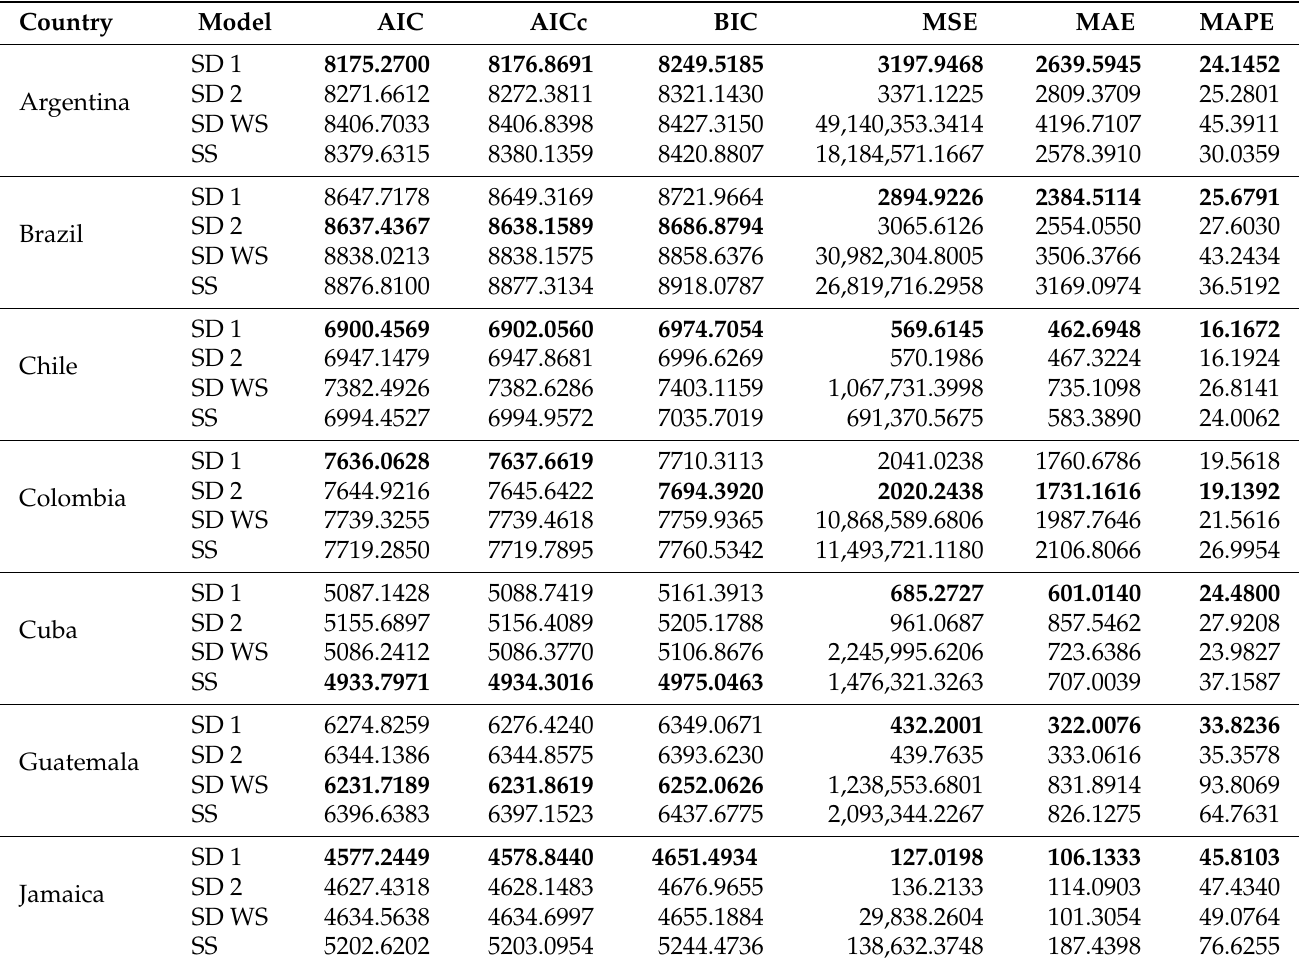
Table 3. AIC, AICc, BIC, and loss functions (forecasting window: last 14